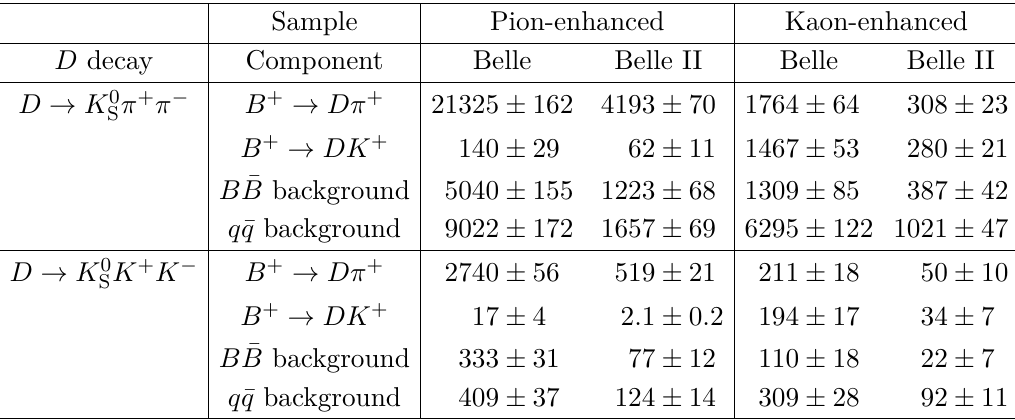
Table 2 . Signal and background yields obtained from the two-dimensional combined fit.